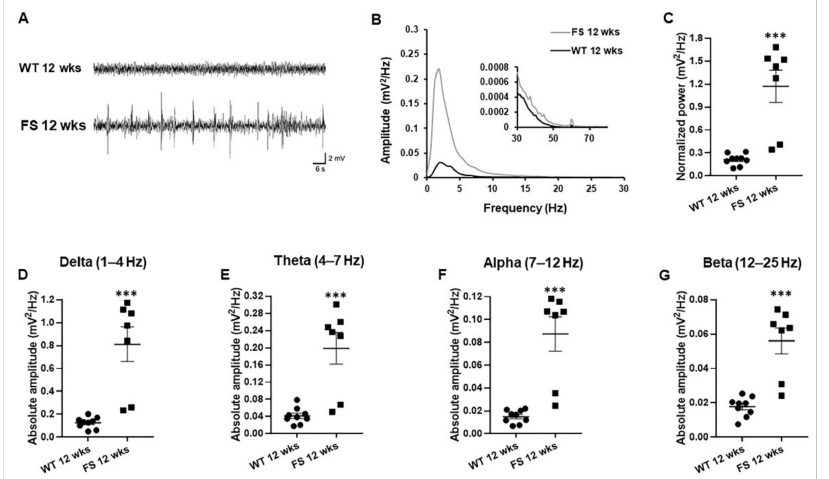
Figure 5. Increased delta, theta, alpha, and beta oscillations in the hippocampus of adult FS rats. Wild- type rats had generally representative LFP signals ( A ). Increased amplitude spikes of irregularly sharp wave and multispikes were examined in LFP signals of FS 12 weeks rats in comparison with littermate wild-type rats ( A ). Power spectral analysis showed that amplitude power at approximately 1–10 Hz frequency in FS 12 weeks rats was larger than that in wild-type rats after 12 weeks ( B ). Representative power spectral analysis showed that averaged and normalized amplitude power in FS 12 weeks rats was stronger than that in wild-type rats after 12 weeks ( C ). Neuronal activities at 1–25 Hz frequency, including delta ( D ), theta ( E ), alpha ( F ), and beta waves ( G ), in FS 12 weeks rats were increased in comparison with those in wild-type littermates. Data are presented as means ± standard errors of the mean. *** p < 0.001, two-tailed t -test (WT 12 weeks, n = 9; FS 12 weeks, n =